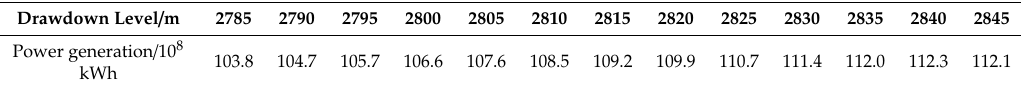
Table 4. Results of power generation and guaranteed rate of Lianghekou under di ff erent drawdown levels.